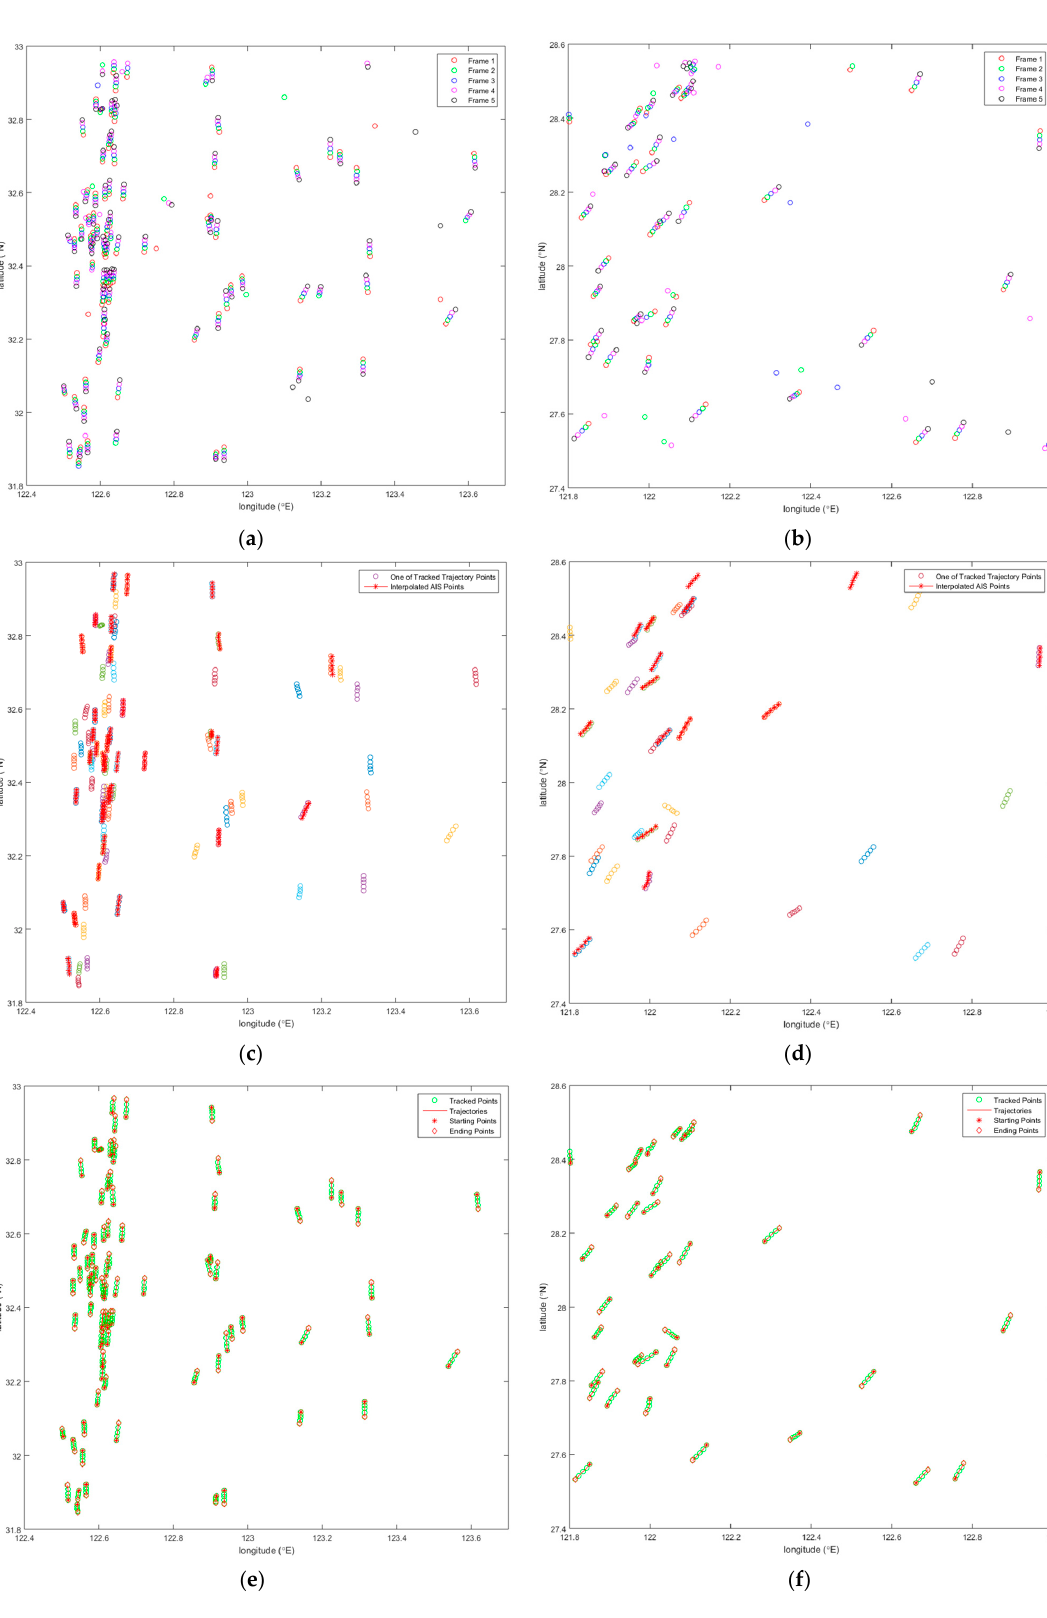
Figure 13. The results of ship detection and tracking in GF-4 image sequences: ( a , b ) are ship detection results of two ROIs in all five frames; ( c , d ) are ship tracking results of two ROIs along with AIS data for veri fi cation; ( e , f ) are ships’ trajectories in the two ROIs. Di ff erent colors of circles denote trajectories of di ff erent ship targets in the sub fi gure ( c , d ).